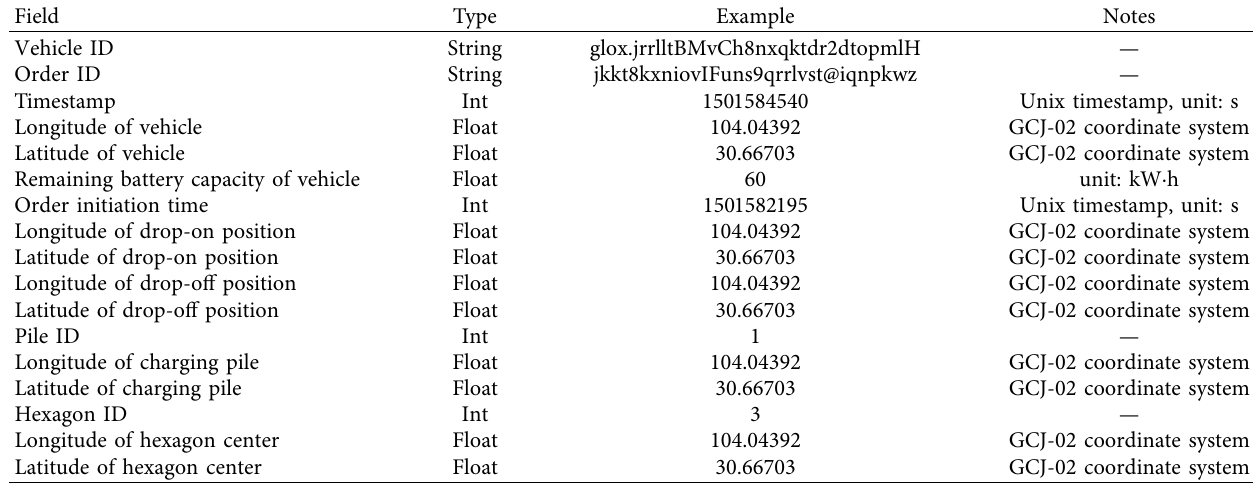
Table 5: The FieldInfo of dataset.